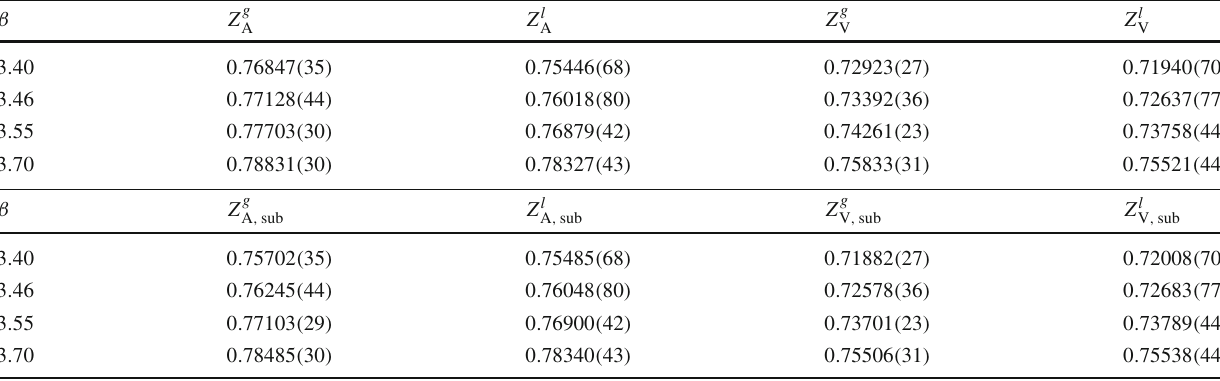
Table 6 N f = 3 results for Z A , V using the L 1 -LCP, both for g and l definitions. The lower part of the table contains the results after subtraction of the one-loop cutoff effects, cf. Eq.